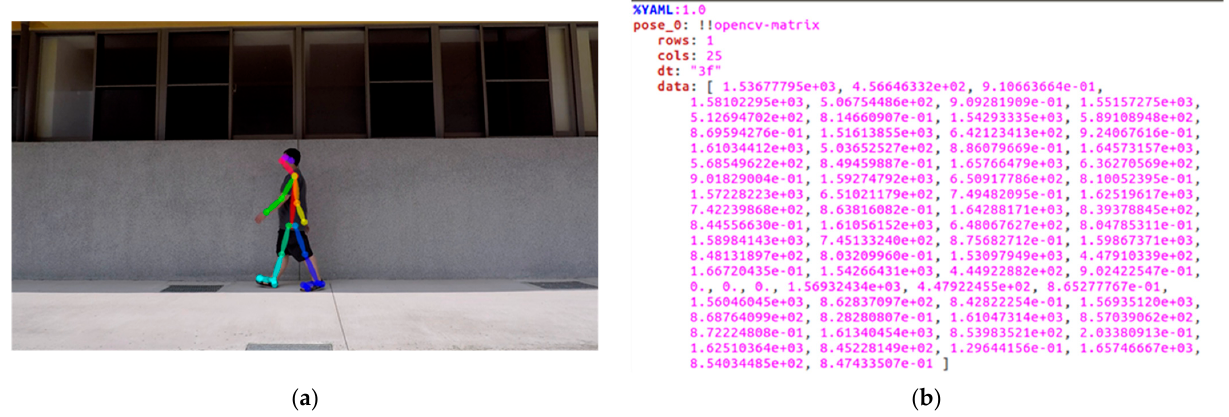
Figure 5. ( a ) OpenPose skeleton; ( b ) the yml file obtained from